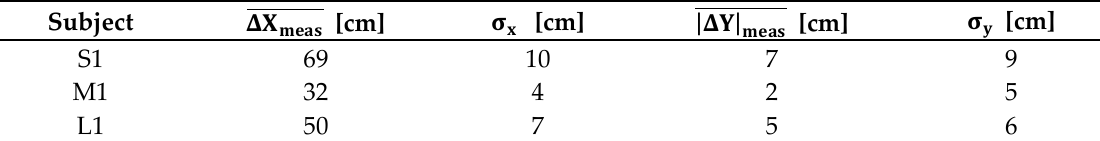
Table 2. Mean longitudinal and lateral separations for each cyclist in trailing position and the corresponding standard deviation obtained from 10